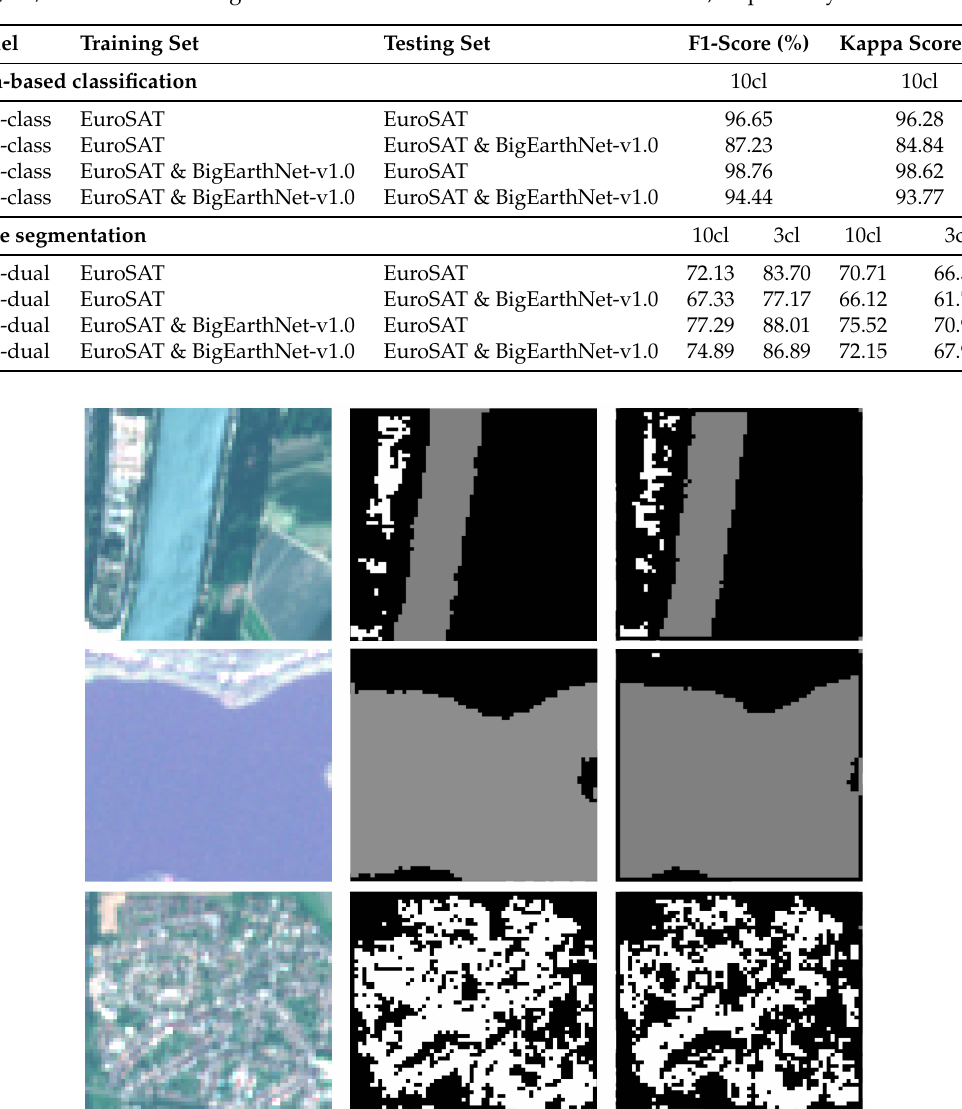
Table 5. Accuracy performance by the proposed CNN modelling approaches, computed via tenfold cross-validation. The training, validation, and testing sets have been partitioned according to the rule